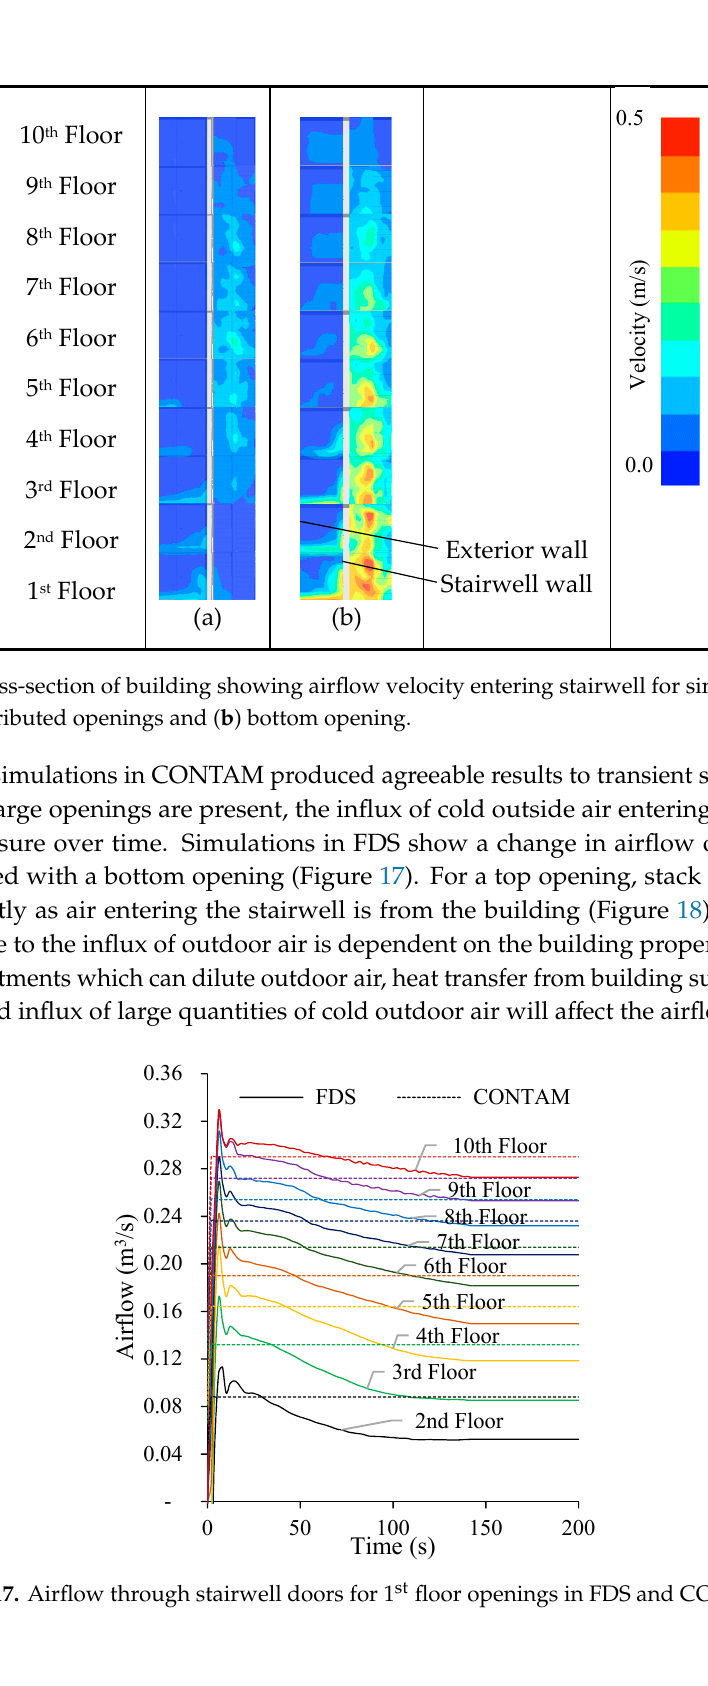
Figure 15. Stairwell stack pressure for average envelope and leaky closed door simulations with openings measured in FDS at mid-floor height.